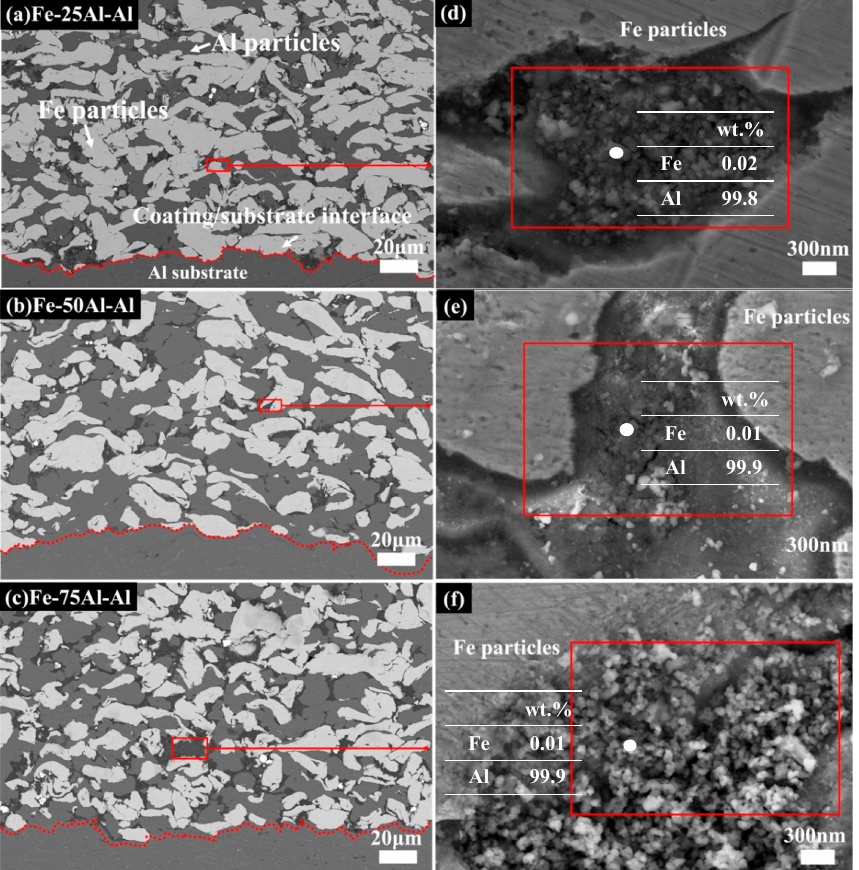
Figure 3. BSE images of cross ‐ section of samples ( a – c ) and partial enlarged SEM images ( d – f ) with the results of the EDX spot analysis.